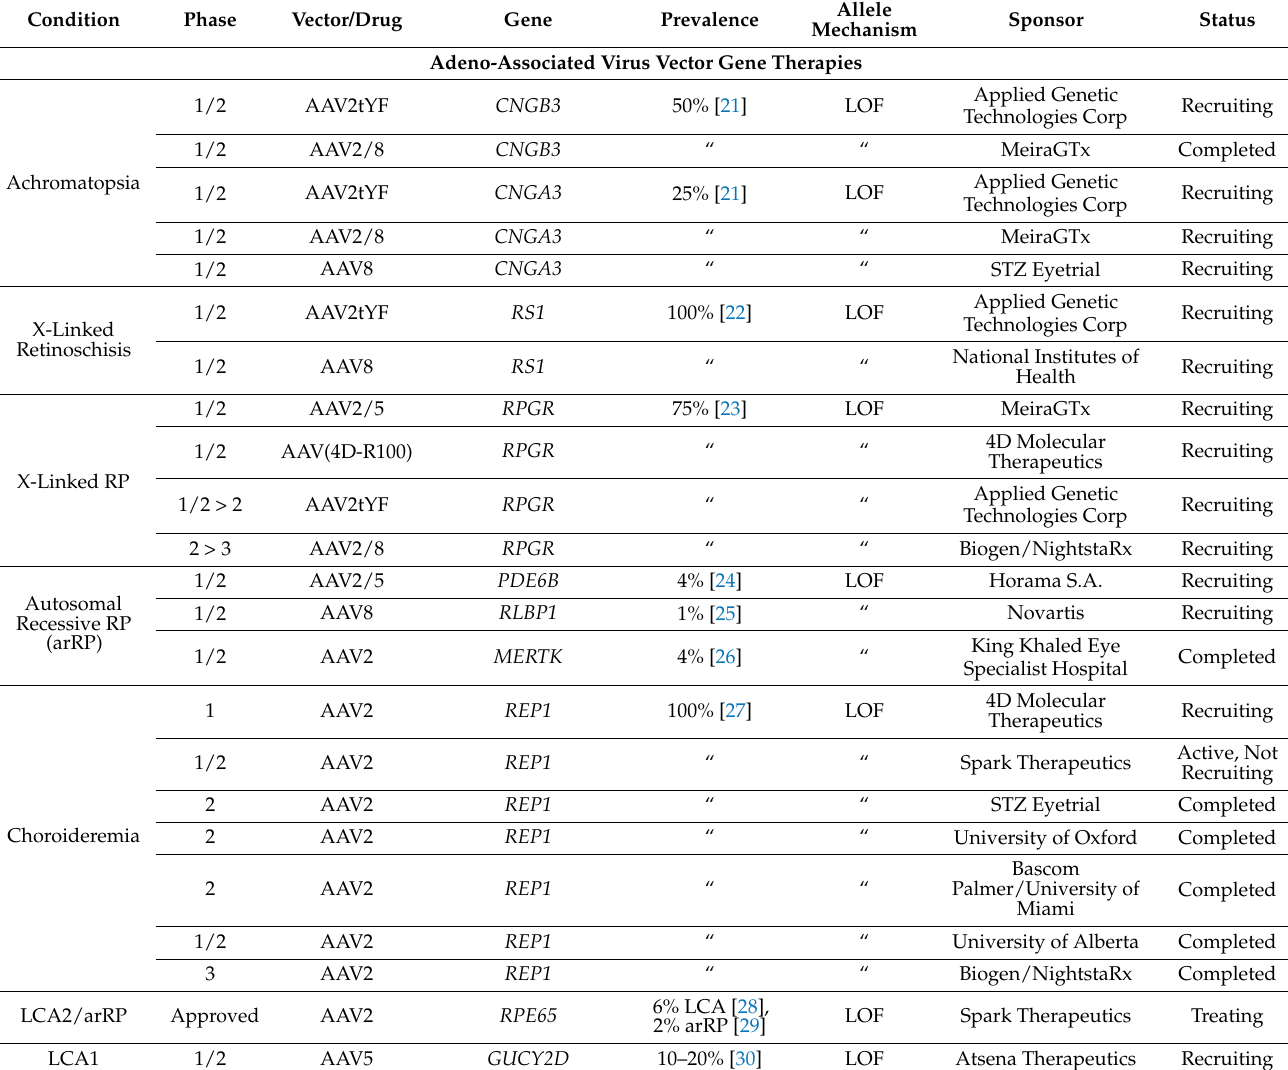
Table 1. Recent clinical trials for retinal dystrophies arranged by condition and therapeutic approach [21–37]. Condition Phase Vector/Drug Gene Prevalence Allele